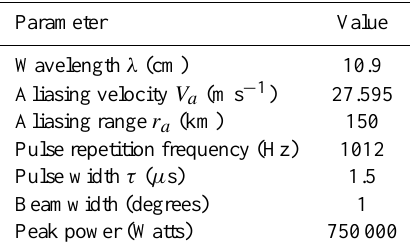
Table 2. Typical operating parameters of the KOUN polarimetric